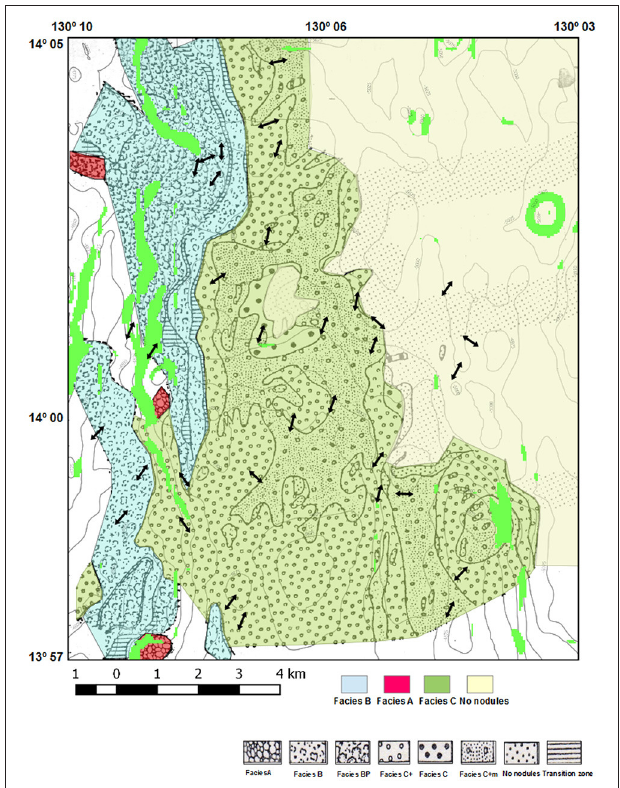
FIGURE 4 | Modified from Du Castel (1985); NIXO 45 GIS Bathymetry, currents and the 4 main Facies represented. The areas with slope greater than 15 ◦ are highlighted in green. Bottom current directions derived from the analysis of imagery of the seabed, in particular of the direction of suspension